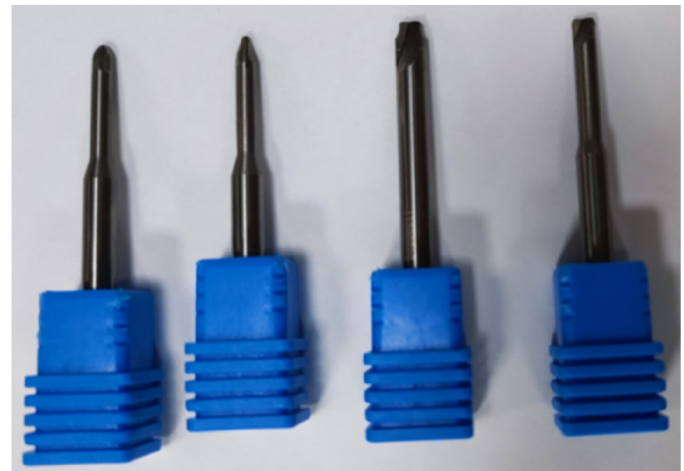
Figure 10. Tools for actual machining.